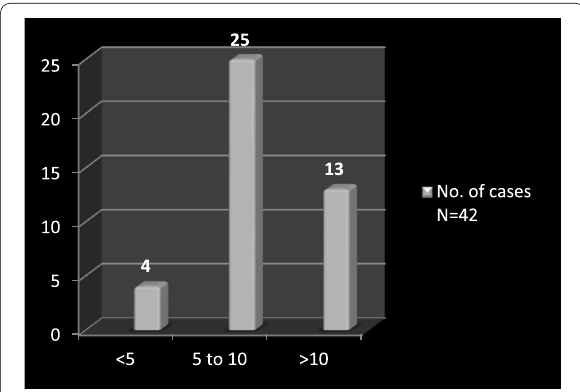
Fig. 1 Age distribution. The majority of children in our study are falling under the age group 5 to 10